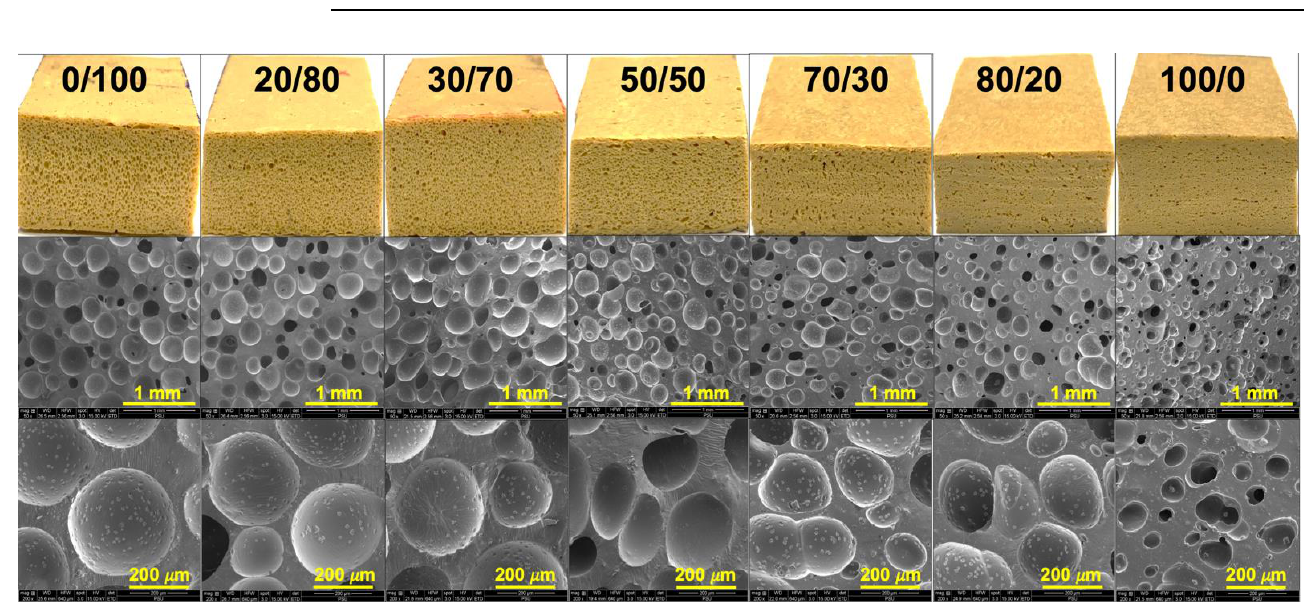
Figure 4. SEM images obtained from the samples’ surface of SR/NR blends .